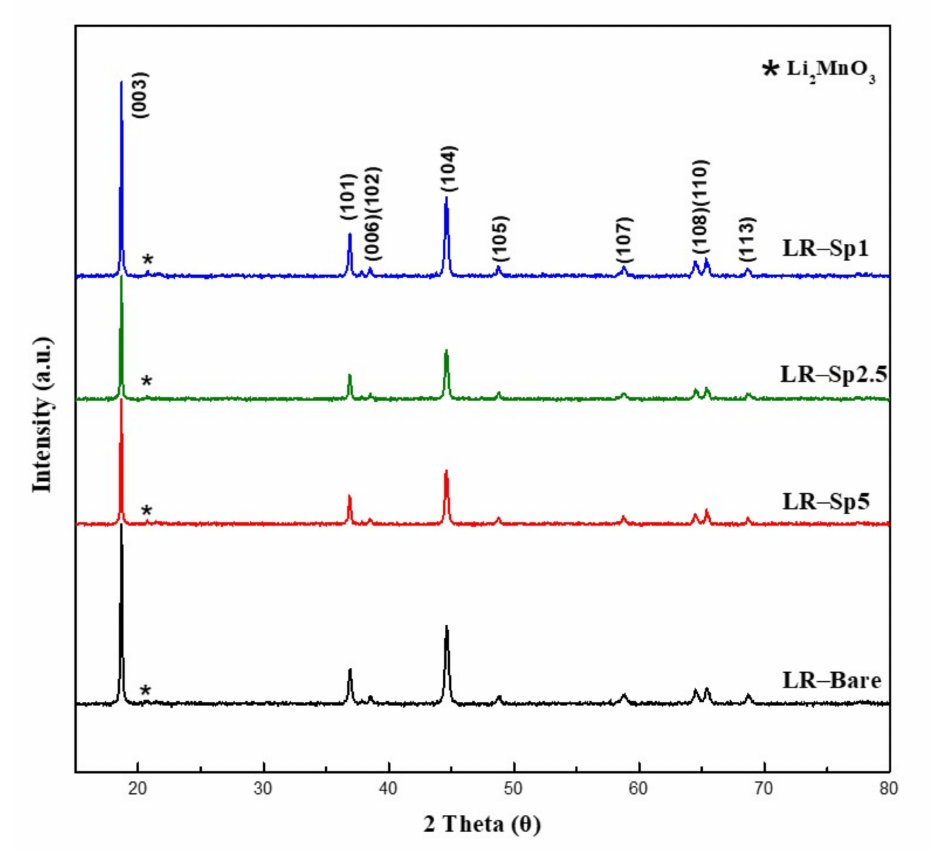
Figure 4. X–ray diffraction (XRD) patterns of the LR–Bare, LR–Sp1, LR–Sp2.5, and LR–Sp5